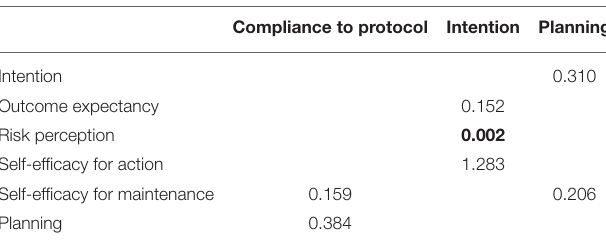
TABLE 10 | F -square.